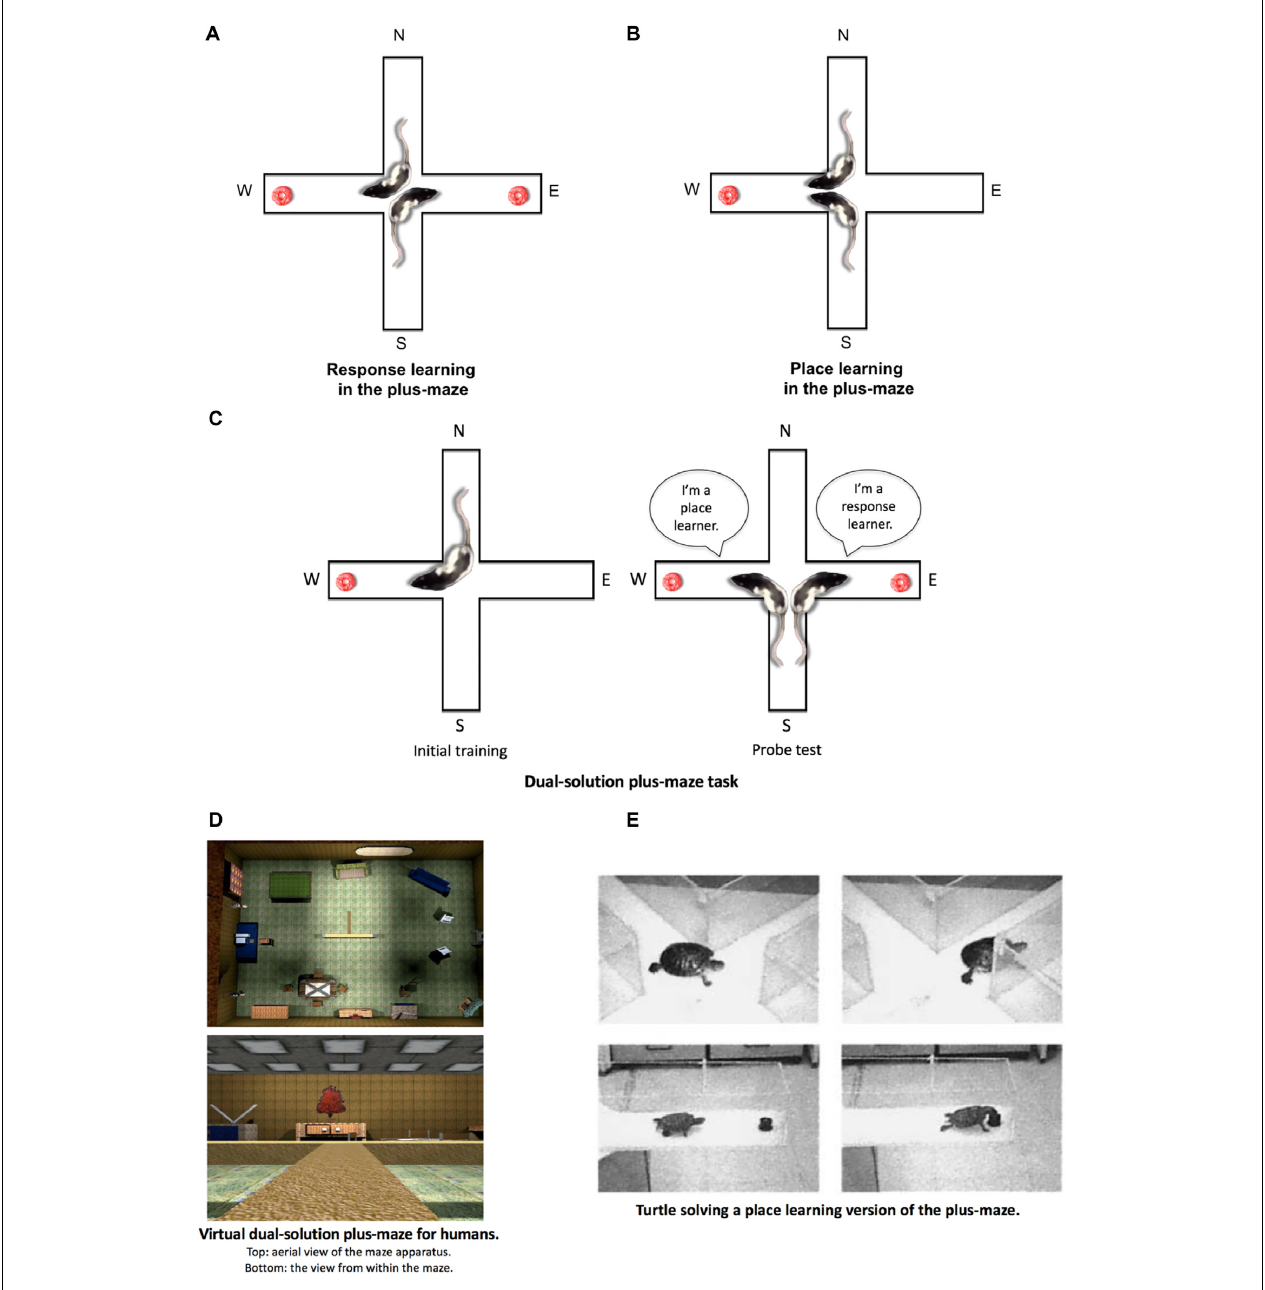
FIGURE 4 | Place and response learning in the plus-maze. (A) In the response learning plus-maze task, a rat is released from opposite start arms (e.g., N and S) throughout training, and the same body-turn response at the choice point is reinforced. For example, when the rat is released from the N arm, food is located in the W arm. When the rat is released from the S arm, food is located in the E arm. In this example, a right-body turn at the choice point is being reinforced. (B) In the place learning plus-maze task, a rat is released from opposite start arms throughout training, while the food remains in a consistently reinforced spatial location. (C) During initial training in the dual-solution plus-maze task, a rat is released from a consistent start arm (e.g., N) with food also located in a consistent spatial location (e.g., W). A rat can learn to retrieve food using a place learning strategy (i.e., go to the same place) or a response learning strategy (i.e., make the same body turn at the choice point). To determine how the rat learned to solve the task, a probe trial is conducted in which the rat is started from the opposite arm (e.g., S). If the rat continues to make the same body-turn at the choice point, the rat is labeled a response learner. If the rat makes the opposite body-turn to return to the reinforced spatial location, the rat is labeled a place learner. (D) A virtual version of the dual-solution plus-maze task may be employed to study place and response learning in human subjects (images from Astur et al., 2016). (E) Place and response learning tasks have been employed to study learning and memory across a variety of species aside from rodents and humans, including turtles, salamanders, chickens, horses, and sharks, among others (image from Salas et al., 2003 with permission from S. Karger AG, Basel).